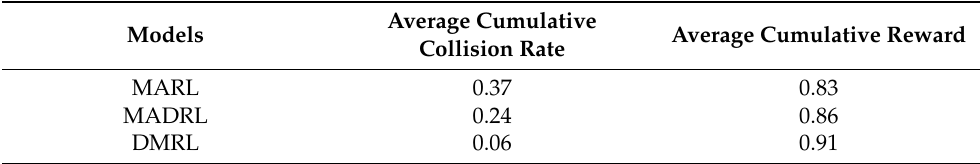
Table 3. Comparison of different cooperative sensing